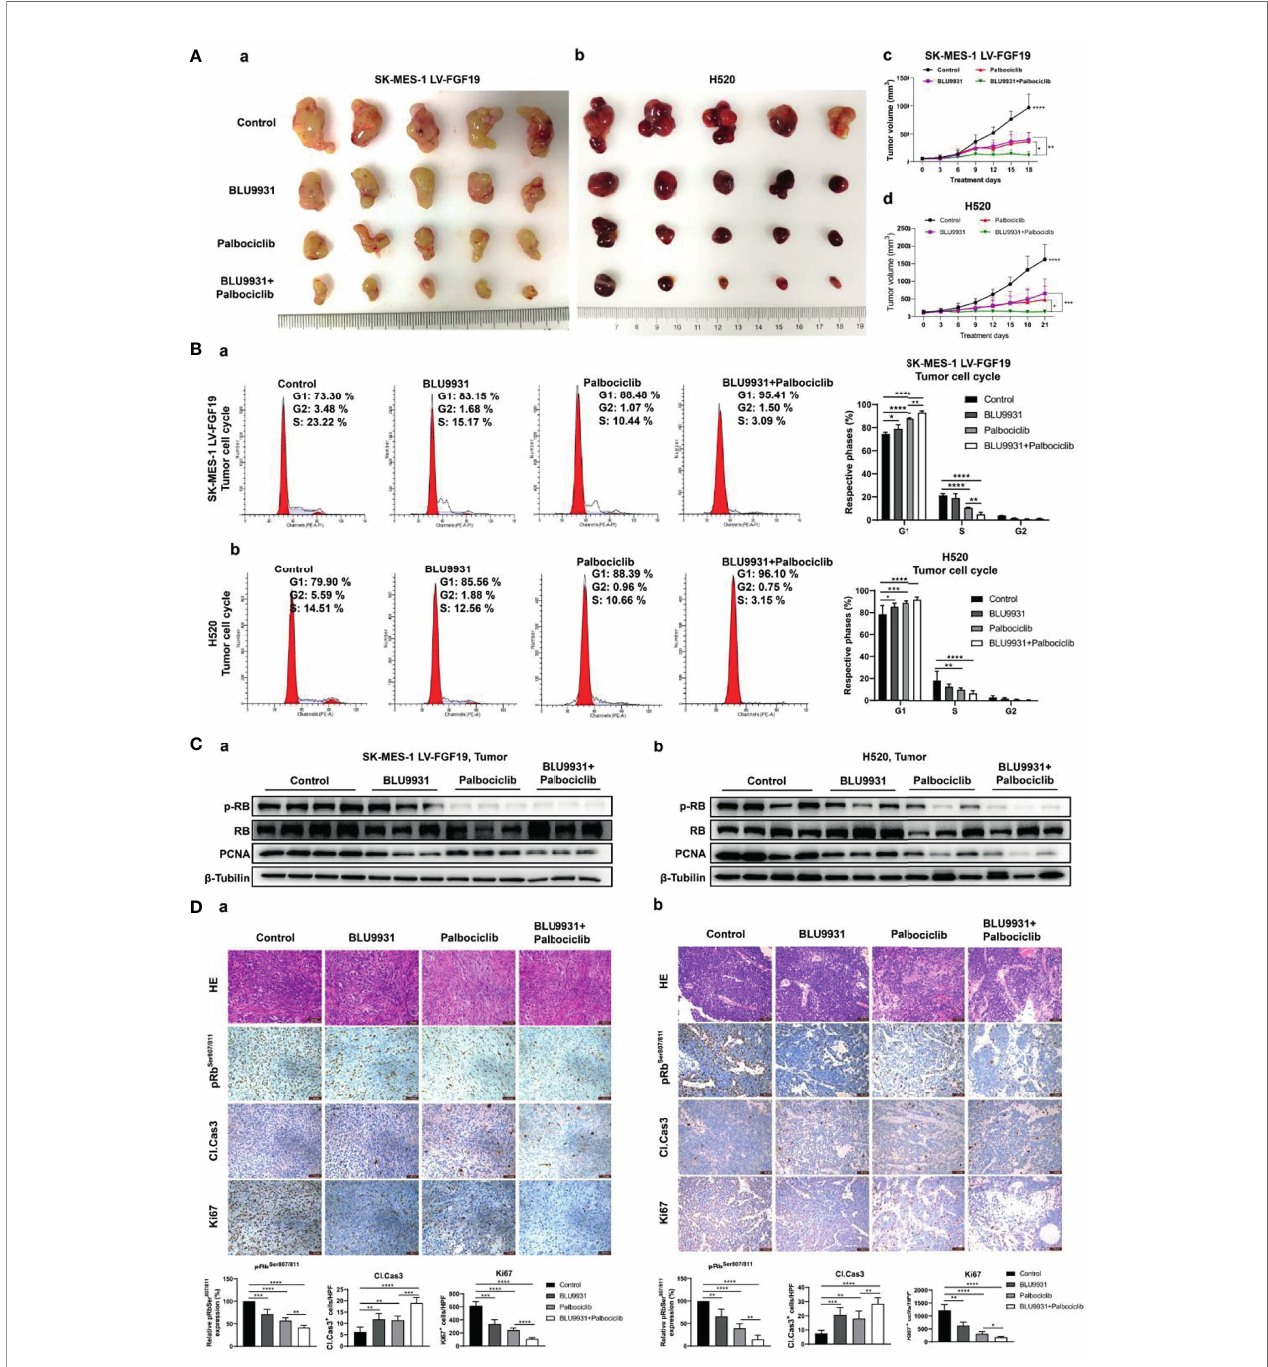
FIGURE 7 | Enhanced effects of combined BLU9931 and palbociclib in the animal model of LUSC cells with endogenously or exogenously high expression of FGF19. SK-MES-1 LV-FGF19 (exogenous FGF19 highly expressed LUSC cells) cells or H520 (endogenous FGF19 highly expressed LUSC cells) cells in a volume of 50 m l were subcutaneously injected into the right fl anks of BALB/c nude mice. When the tumor reached a volume of 100 – 200 mm 3 , mice were randomly grouped and orally treated with vehicle, BLU9931 (30 mg/kg, twice a day), palbociclib (100 mg/kg/d), or both drugs in combination for 3 weeks. Tumor volumes were measured every 3 days after the onset of treatment. (A) The tumors were dissected from the mice. (a) SK-MES-1 LV-FGF19 xenograft tumors and (b) H520 xenograft tumors. Growth curve for (c) SK-MES-1 LV-FGF19 and (d) H520 xenograft tumors. (B) Representative histograms depicting cell cycle pro fi les of tumor cells and quanti fi cations of the histograms. (a) SK-MES-1 LV-FGF19 xenograft tumors; (b) H520 xenograft tumors. (C) The expression of pRB and PCNA in (a) SK- MES-1 LV-FGF19 xenograft tumors and (b) H520 xenograft tumors were detected by western blot. (D) HE and immuno fl uorescence staining with pRb Ser807/811 , cleaved caspase 3 (Cl. Cas3) and Ki67 of tumor sections. (a) SK-MES-1 LV-FGF19 xenograft tumors; (b) H520 xenograft tumors. Data were shown as mean ± SD and * p < 0.05, ** p < 0.01, *** p < 0.001 and **** p < 0.0001 as calculated by the two-way ANOVA test. Scale bar: 50